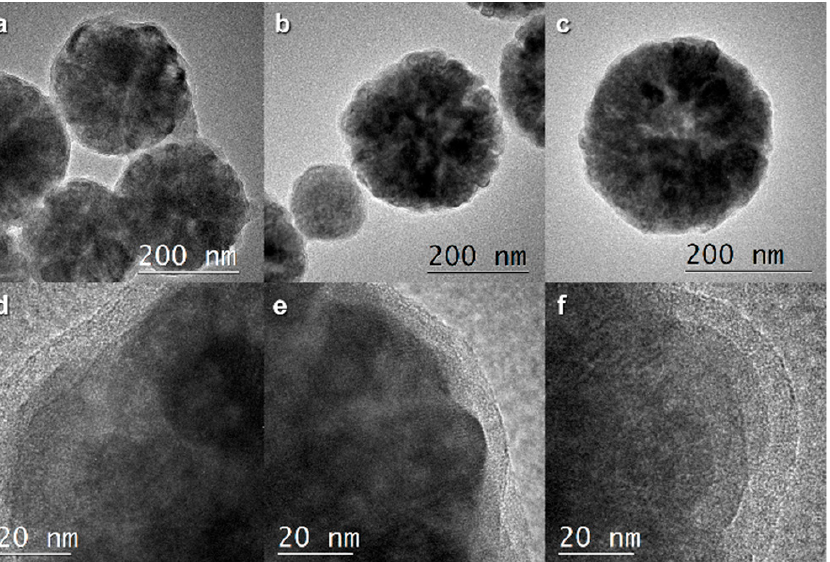
Figure 2. TEM images of the phenylboronic ‐ acid ‐ modified magnetic nanoparticles: Fe 3 O 4 @MPTES@VPBA ( a , d ), Fe 3 O 4 @MPTES@AAPBA ( b , e ), Fe 3 O 4 @MPS@MPBA ( c , f ).